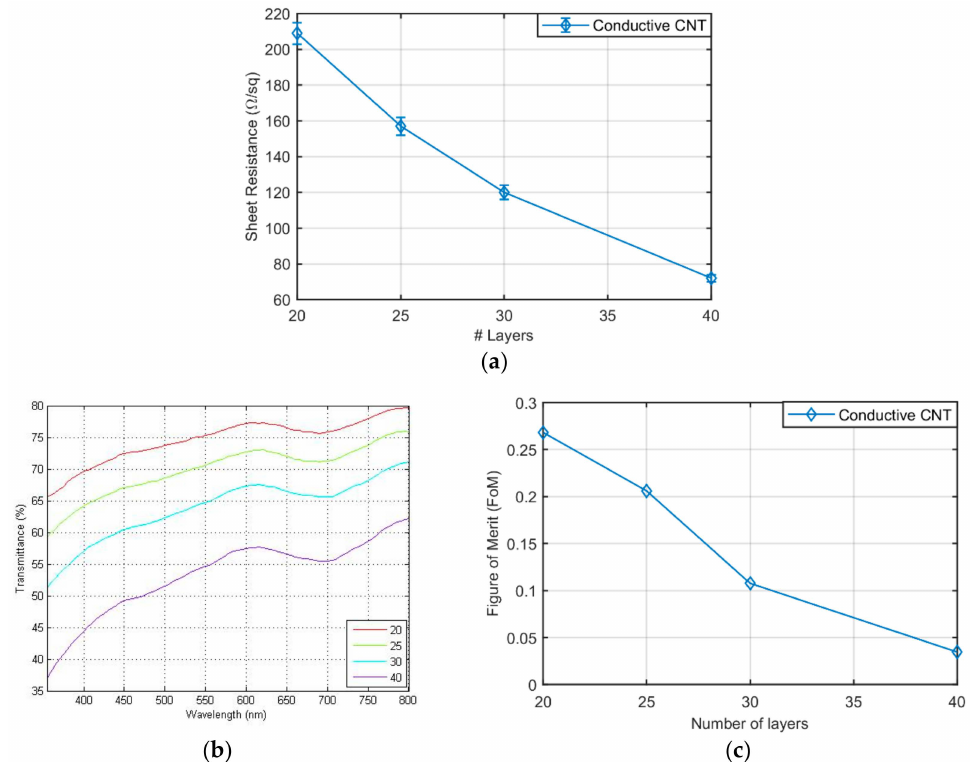
Figure 2. ( a ) Sheet resistance of carbon nanotube (CNT) films with regard to the number of CNT layers sprayed. Corresponding to 48 nm, 60 nm, 74 nm and 97 nm film thickness, for 20, 25, 30 and 40 layers, respectively; ( b ) optical transmittance of CNT layers for electrodes definition; ( c ) electro-optical figure of merit as a function of the number of